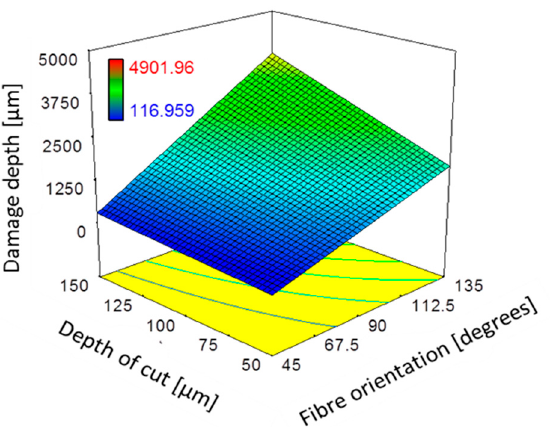
0.91 Table 7. Model coefficients for each output variable. Coeff.